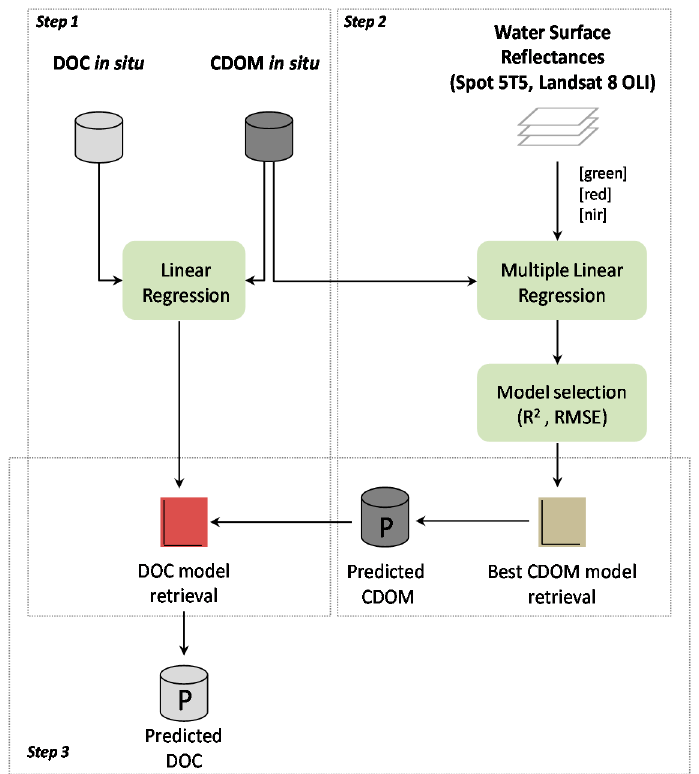
Figure 2. Methodological flowchart illustrating the general procedure to retrieve DOC concentrations. The Step 1 corresponds to the computation of the DOC model retrieval and the Step 2 indicates the procedure used to predict CDOM values. The Step 3 shows how the DOC model retrieval is finally used to predict DOC concentrations.